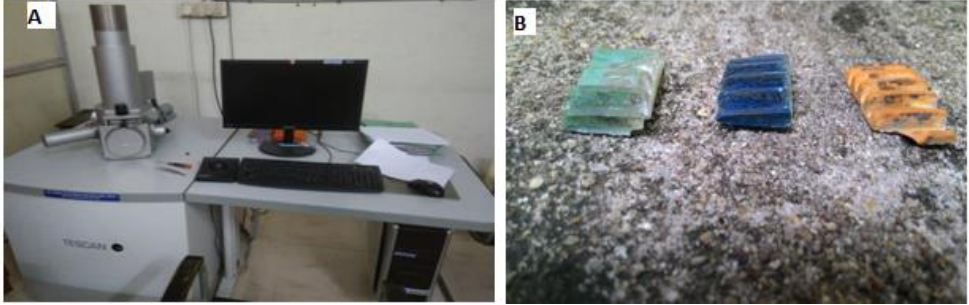
Figure 4. ( A ) Scanning electron microscopes. ( B ) Test samples.